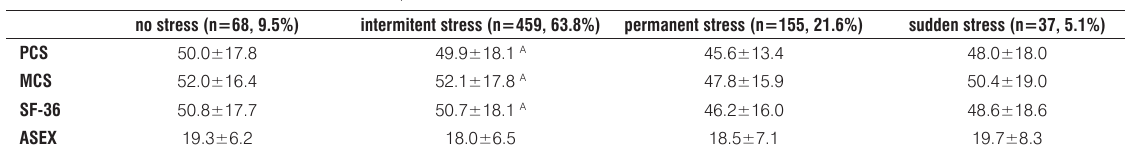
Table 6. HRQoL and ASEX in relation to self-reported